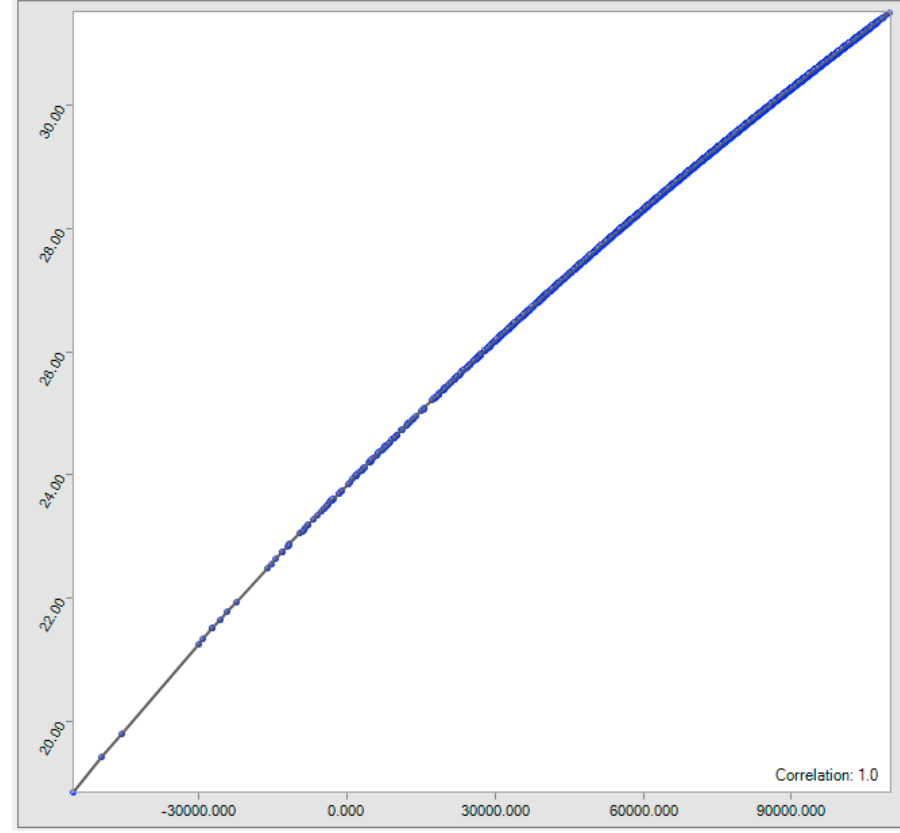
Figure 6. Correlation between the NPV of the project and defined Duration.